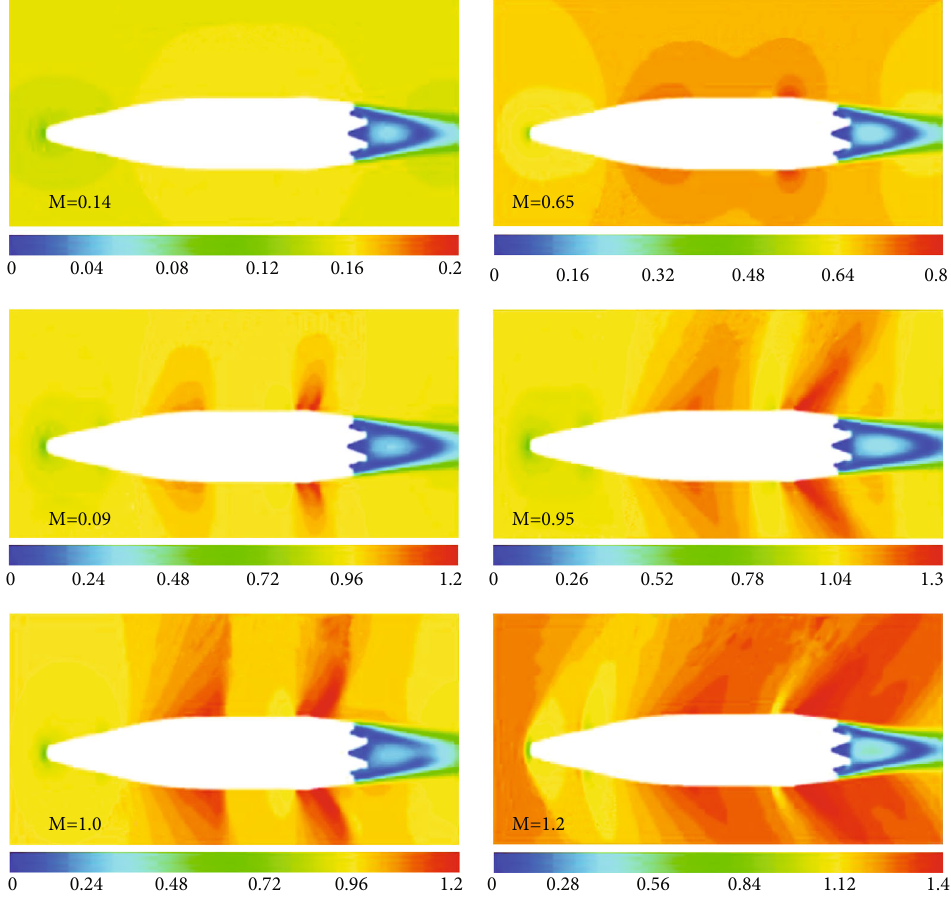
Figure 8: Contour of Mach